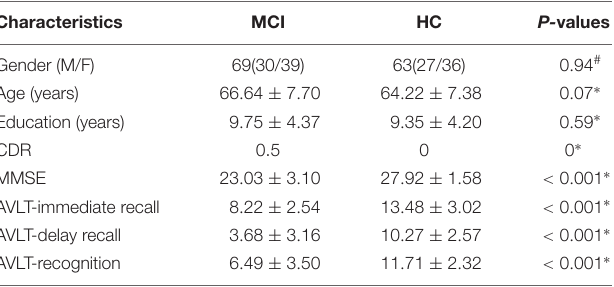
TABLE 1 | Participants’ demographic and clinical characteristics.